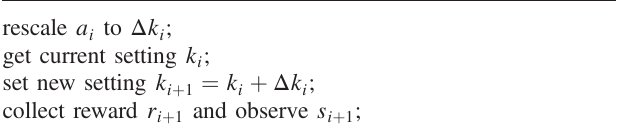
Algorithm 1. add a i to current setting in method step ( a i )